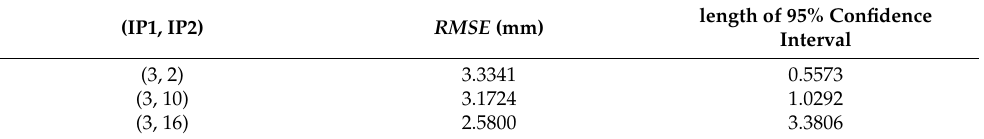
Table 5. The RMSEs and lengths of the 95% confidence interval for specific numbers of IP1 and IP2.